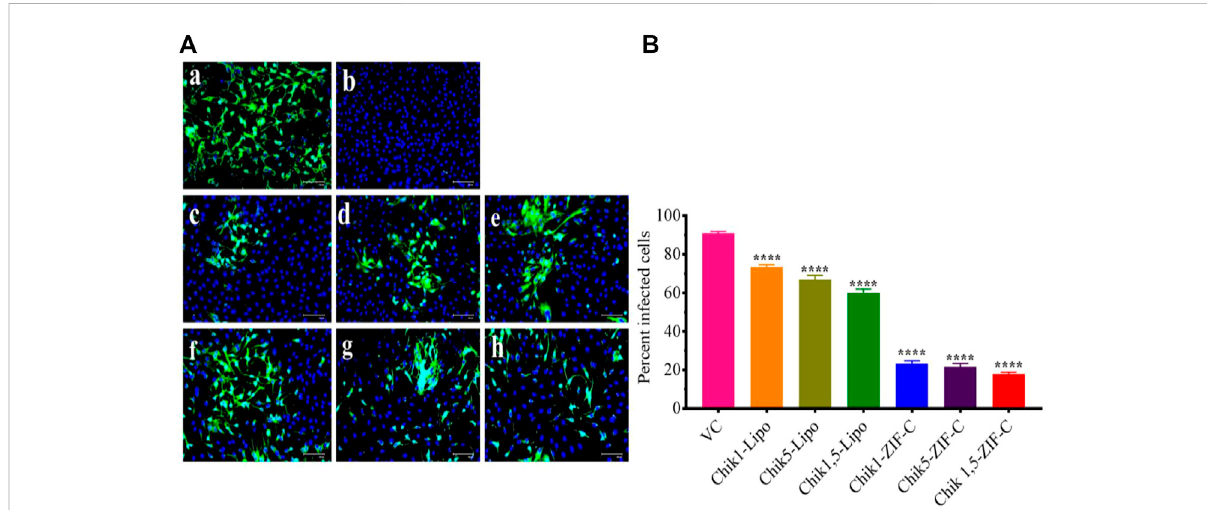
FIGURE 6 EffectofZIF-C-siRNAformulationsandlipofectaminemediatedsiRNAtransfectiononCHIKVinfection.Immuno fl uorescentimages (A) ofVirus Control (A) ; Cell Control (B) ; Chik1-ZIF-C (C) ; Chik5-ZIF-C (D) ; Chik1,5-ZIF-C (E) ; Chik1-Lipo (F) ; Chik5-Lipo (G) ; Chik1,5-Lipo (H) at 0 h.p.i. Virus infected cells are stained green by FITC and the nucleus of the cells is stained blue by DAPI (A) . Percent of infected cells during ZIF-C siRNA and Lipofectamine 2000 siRNA treatment (at 0 h. p.i). Cells were counted in four different fi elds to obtain the percentage of infected cells (B) . The experiments were performed in triplicates inthree independent trials. All the values are expressedas mean ± SEM of three experiments. The percent infected cells were compared between VC and different siRNA formulations using one-way ANOVA with multiple corrections (**** p <